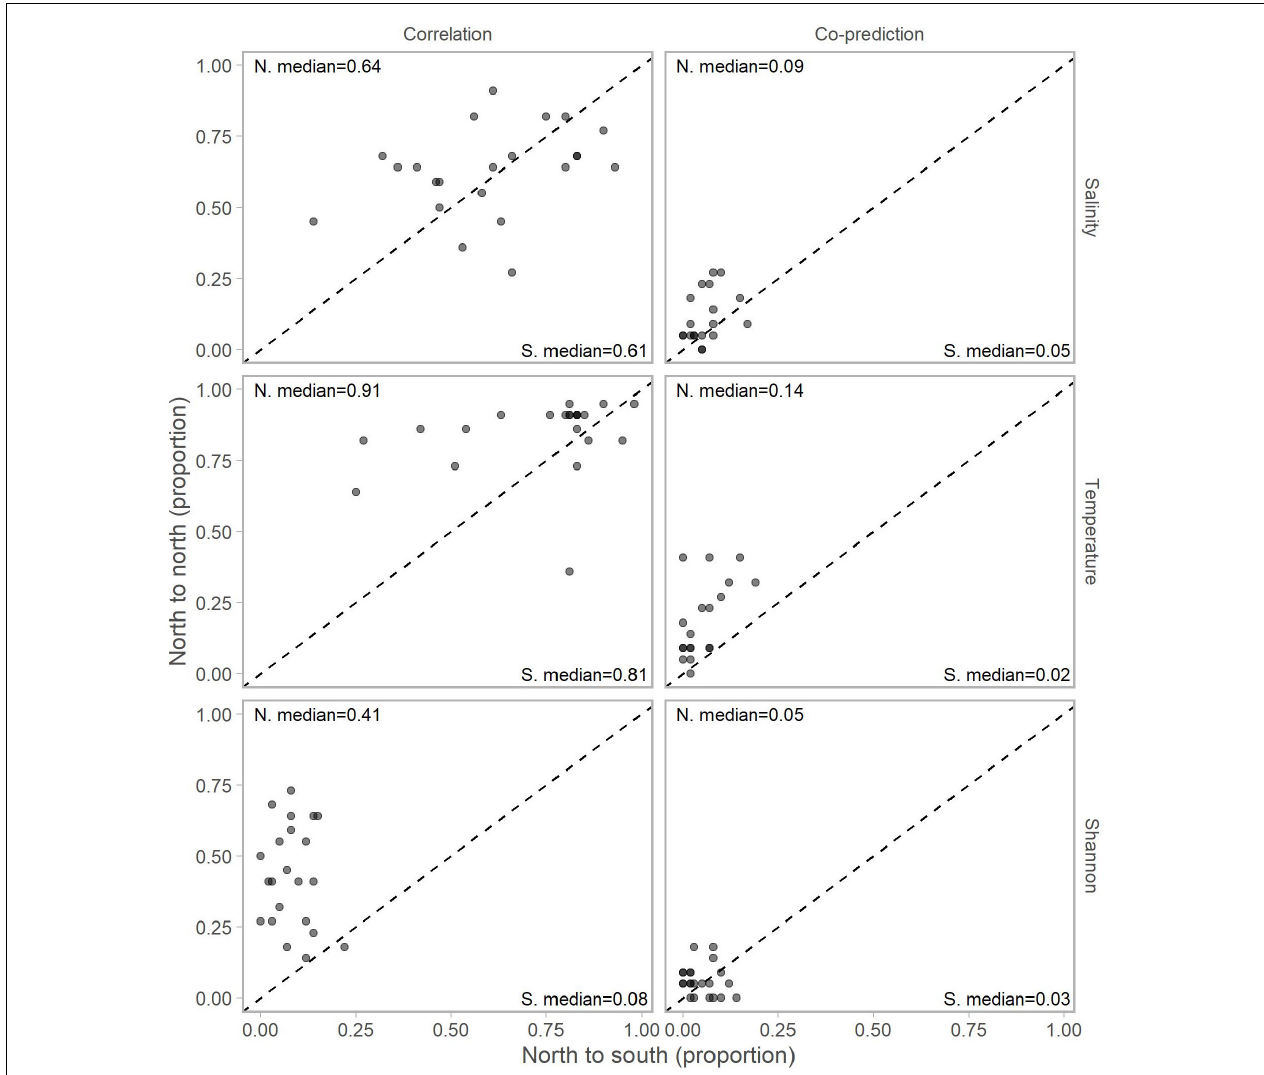
FIGURE 5 | Proportions of north stations correlated (left column) and co-predicted (right column) with stations south (x-axis) and north (y-axis) of Point Conception.There were 59 stations south and 22 stations of Point Conception. Panels show results for the three data types: salinity (top row), temperature (middle row), and Shannon indices (bottom row). The median proportions for predicted stations south (bottom right of each panel) and north (top left of each panel) of Point Conception. The dashed line shows the one-to-one